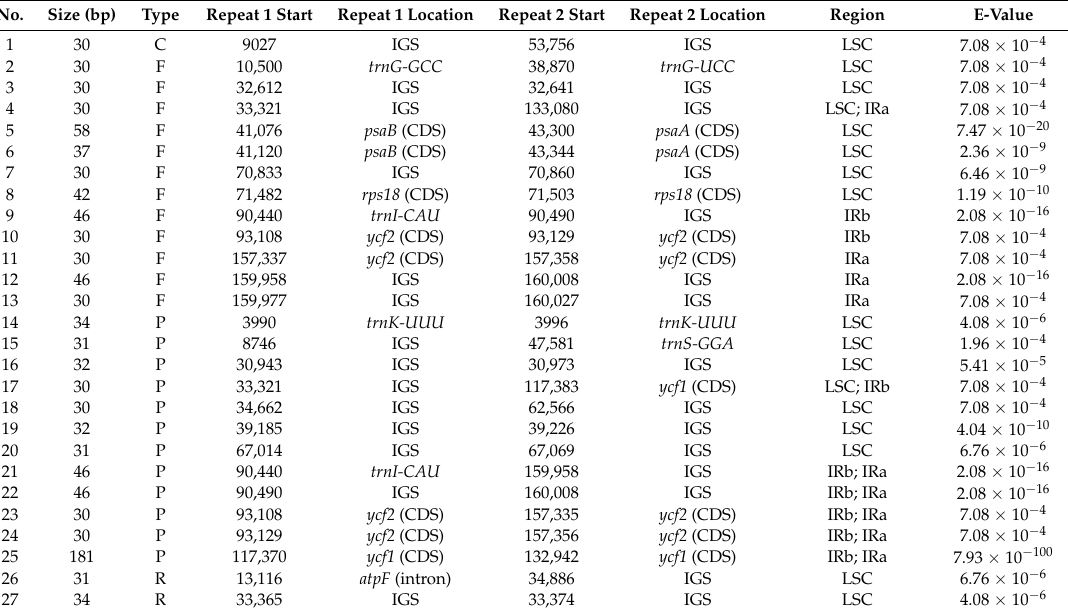
Table 3. Long repeat sequences in the A. kravanh chloroplast